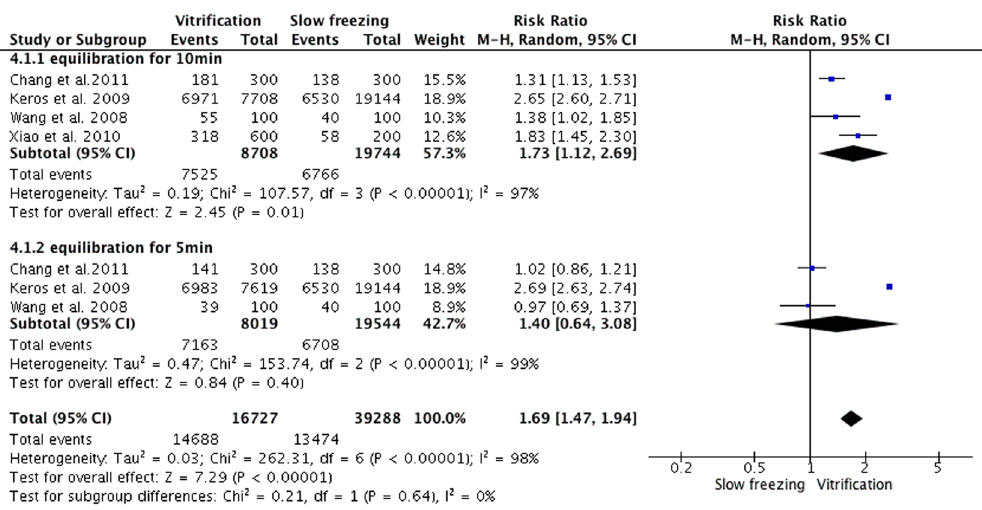
Figure 4. Random effect model of risk ratio with 95% CIs of the proportion of normal stromal cells: slow freezing versus